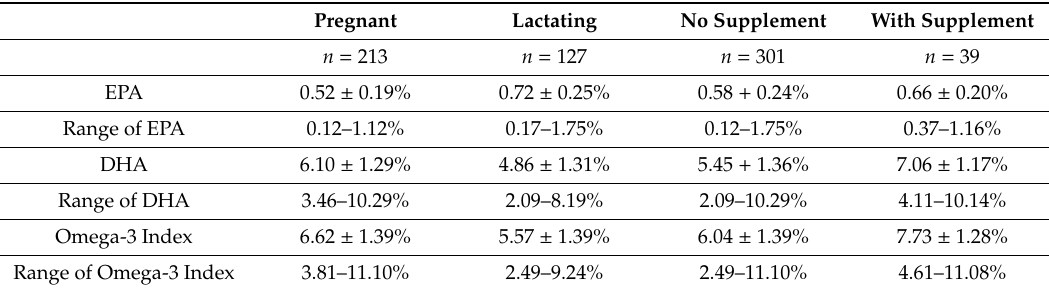
Table 1. Levels of eicosapentaenoic acid (EPA), docosahexaenoic acid (DHA), and the Omega-3 Index in pregnant and lactating women, with and without supplementation with EPA and DHA, in % of a total of 26 fatty acid analyzed using the HS-Omega-3 Index method. Data are from a German nationwide, cross-sectional study [26]. Only 11.5% of women supplemented, while 88.5% did not. Pregnant Lactating No Supplement With